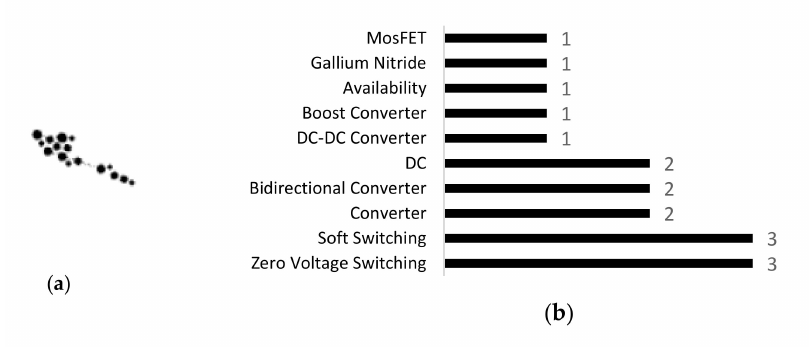
Figure 24. Representation of the DC-DC Converter community: ( a ) Isolated distribution of publications. ( b ) Keywords of the